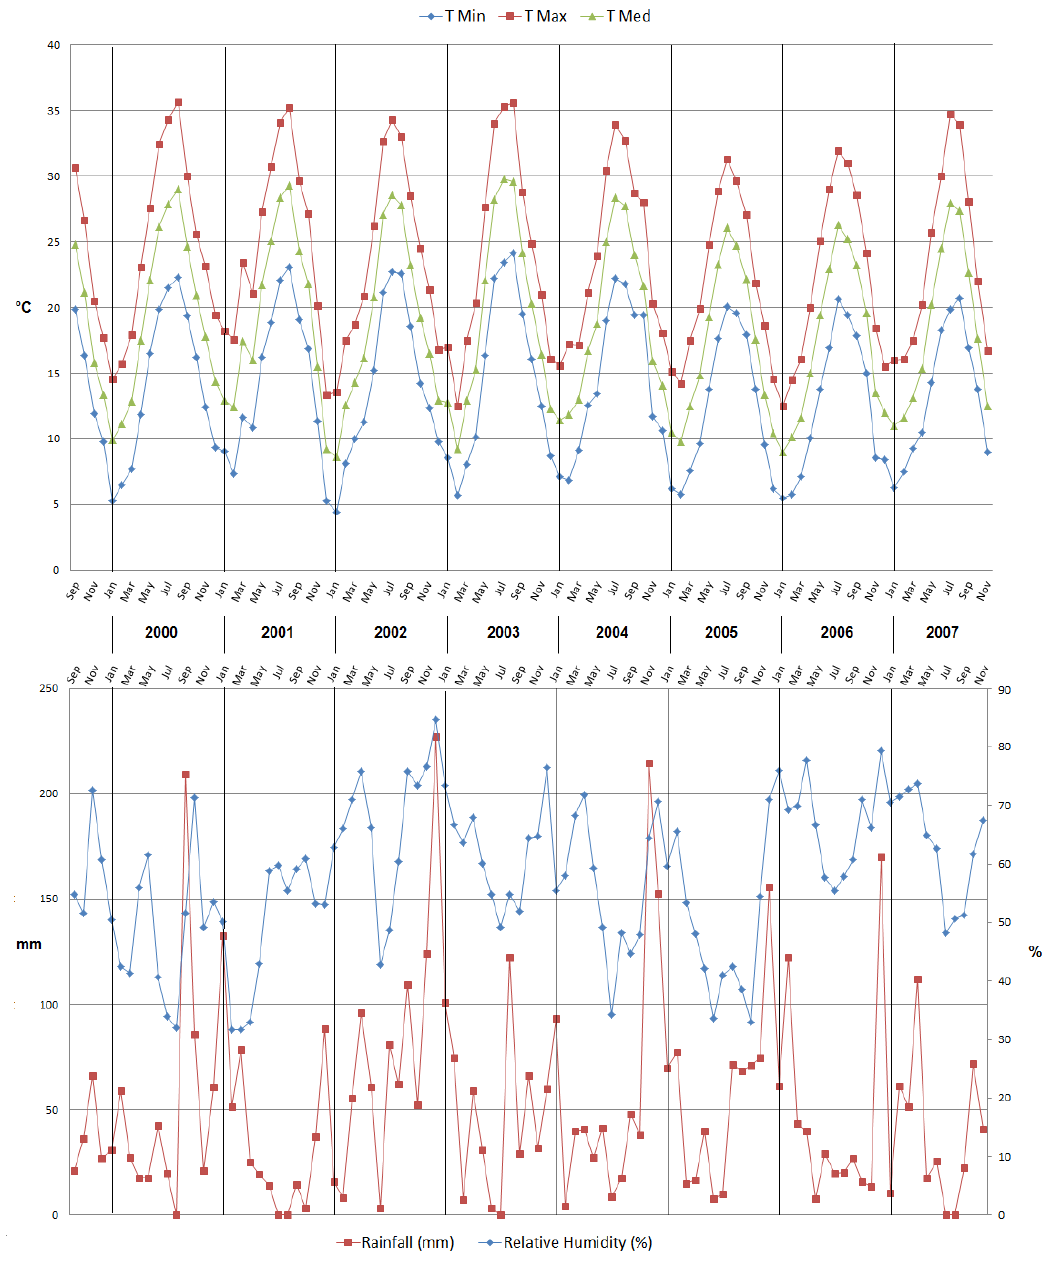
Figure 2. Climatic conditions during the eight-year trial.